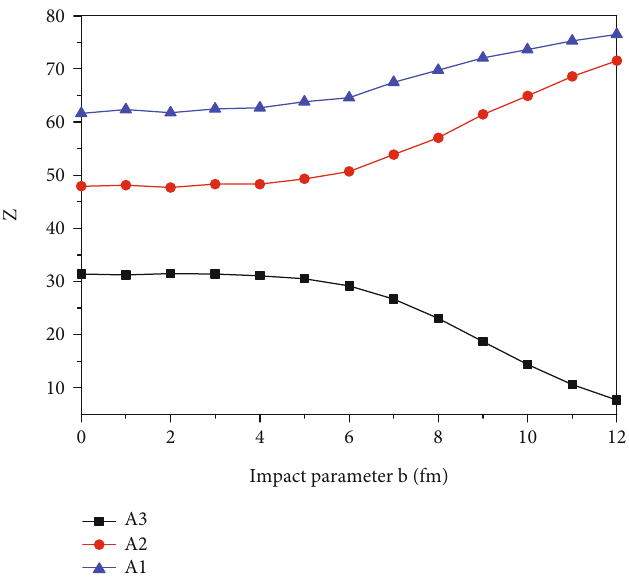
Figure 1: The correlation between the proton numbers of nuclear fragments in ternary fi ssion and the impact parameter.